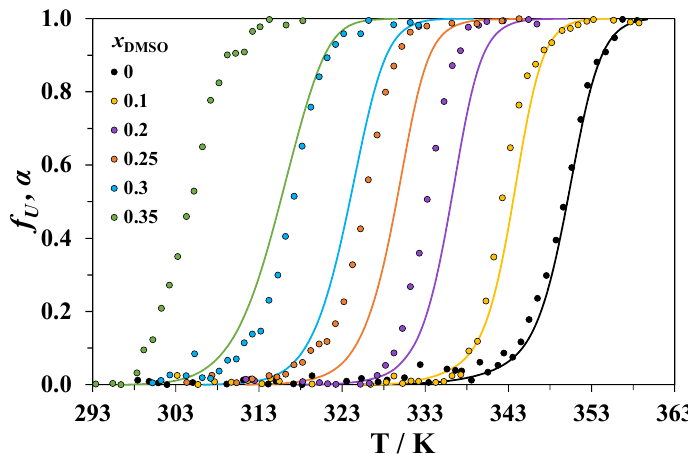
Figure 3. Temperature dependencies of the degree of conversion of lysozyme from the DSC data at a 0.5 K · min − 1 heating rate ( α , solid lines) and a fraction of the lost tertiary structure from the CD measurements ( f U , circles). The data for the mixtures with different mole fractions of DMSO x 1 are shown in different colors.